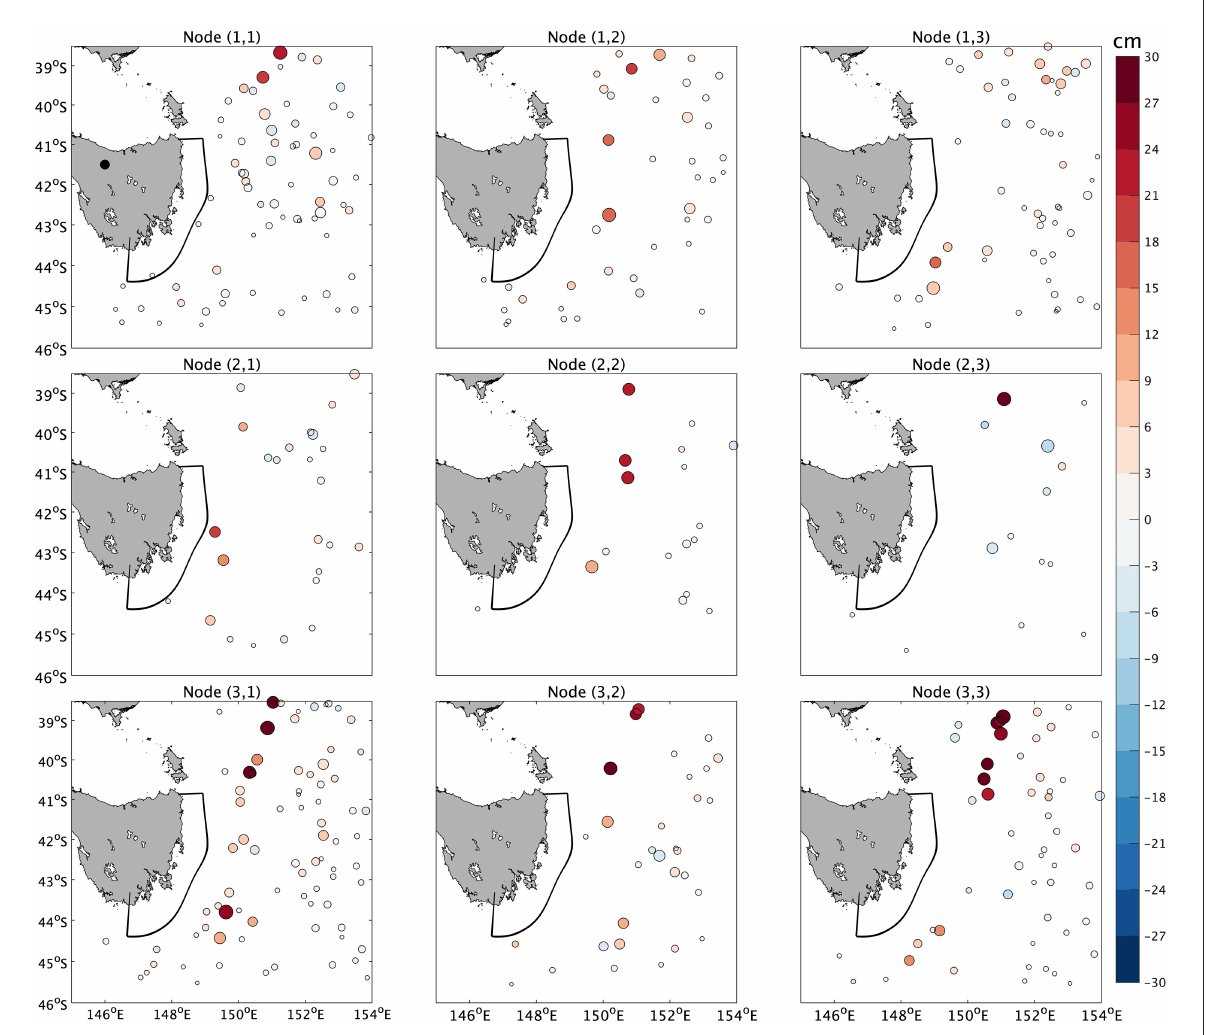
FIGURE6 Eddy distribution in each node. Each eddy is indicated as a dot with colour intensity revealing its mean amplitude (cm) during its lifetime, the size of each dot is proportional to the mean eddy size during the lifetime, and the basic color of each number indicates the intensity of this eddy, where red (blue) stands for anticyclonic (cyclonic)